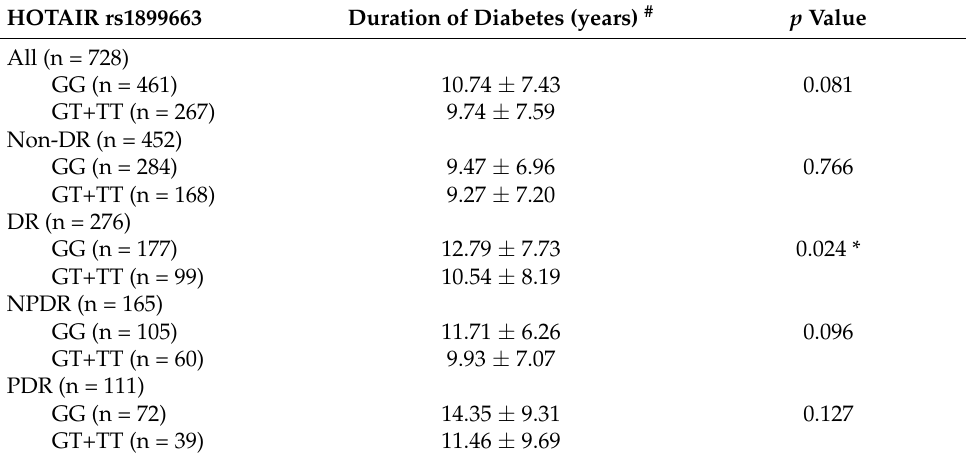
Table 6. Duration of diabetes in diabetic patients according to HOTAIR rs1899663 genotypes. HOTAIR